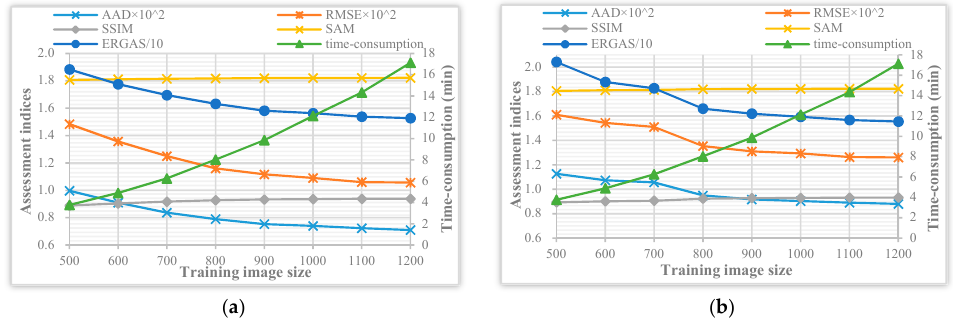
Figure 4. Graphical assessment indices of the proposed bi-directional fusion with spatially extended training samples from the rural dataset, ( a ) and ( b ) are respectively for modeling the reflectance on 24 May and 11 July 2001.